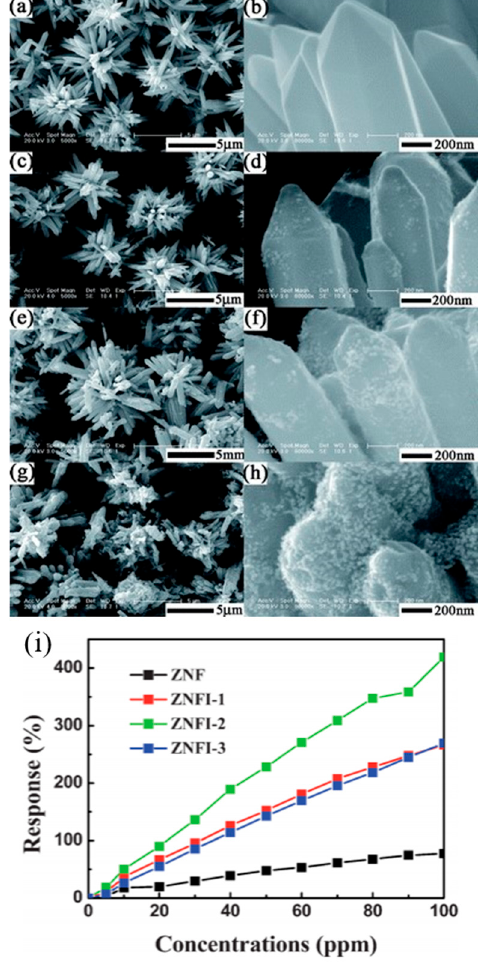
Figure 47. SEM images of ZnO and In 2 O 3 -sensitized ZnO nanoflowers: ( a , b ) pure ZnO nanoflowers; ( c , d ) ZNFI-1; ( e , f ) ZNFI-2; ( g , h ) ZNFI-3; ( i ) HCHO responses of the ZnO and In 2 O 3 -sensitized ZnO nanoflowers under 460 nm photon irradiation. Reproduced with permission from [72].